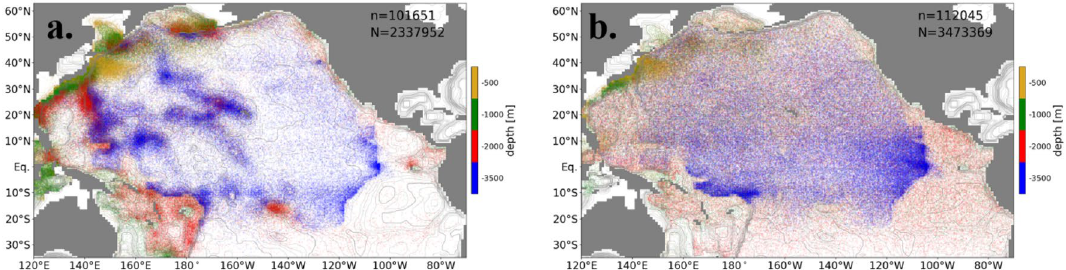
Figure 6. The horizontal positions where particles first cross the 500 (yellow), 1000 (green), 2000 (red), and 3500 m depths (blue) in ( a ) the case 3D and ( b ) the case